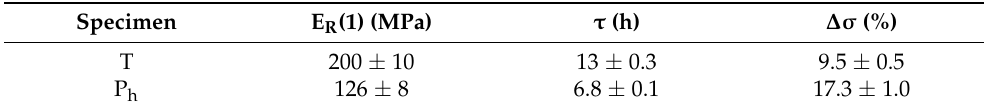
Table 4. Mean and standard deviation values of the mechanical properties calculated from the stress relaxation tests of the as-printed PCL specimens.